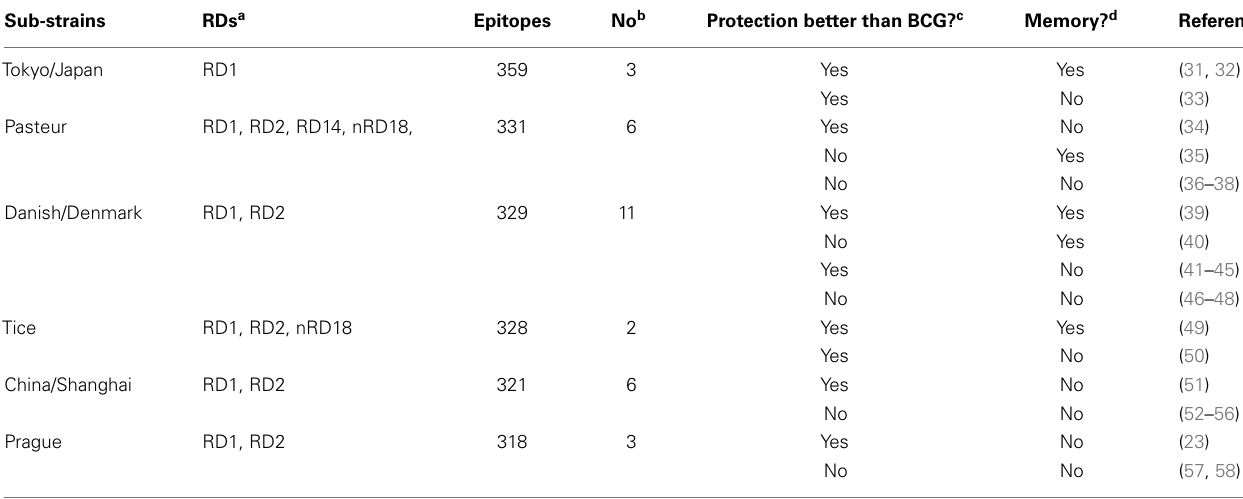
Table 1 | BCG sub-strains genetic background used for recombinant BCG vaccines development and ability to induce memory and protection against